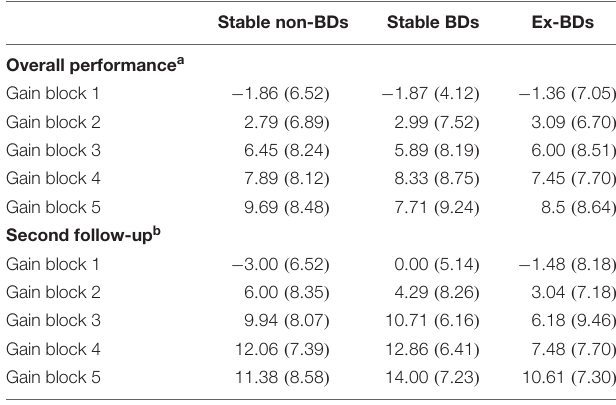
TABLE 1 | Group means (standard deviation) for demographic and clinical data at baseline.